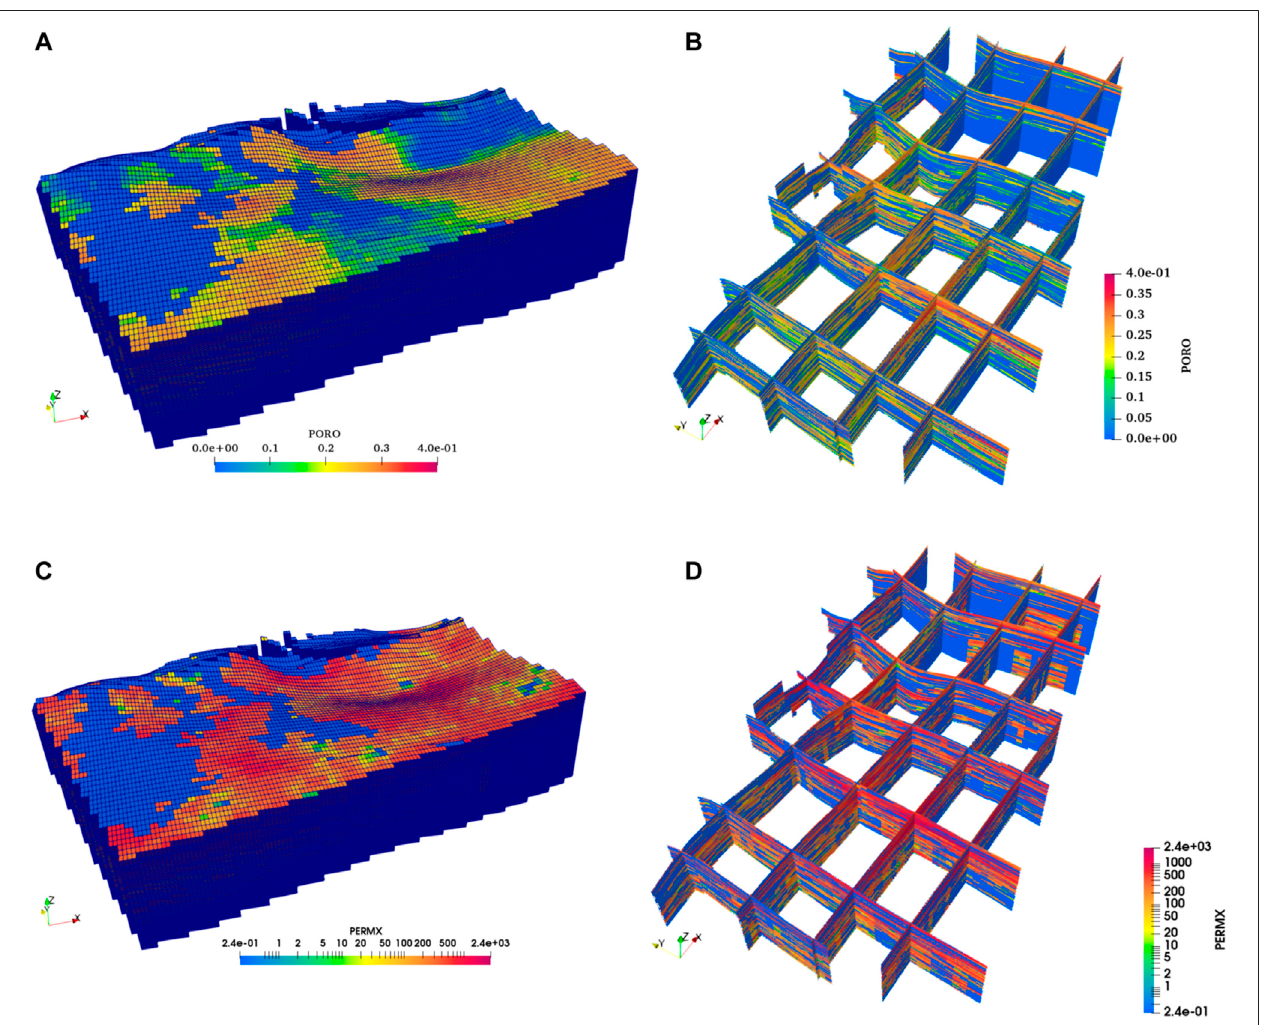
FIGURE 7 | The converted mesh with (A) 3D porosity ( – ) distribution, (B) the cross-section pro fi le of porosity, (C) 3D permeability (mD) distribution, and (D) the cross-section pro fi le of permeability, shown in Paraview. Note that the permeability is presented in log scale.